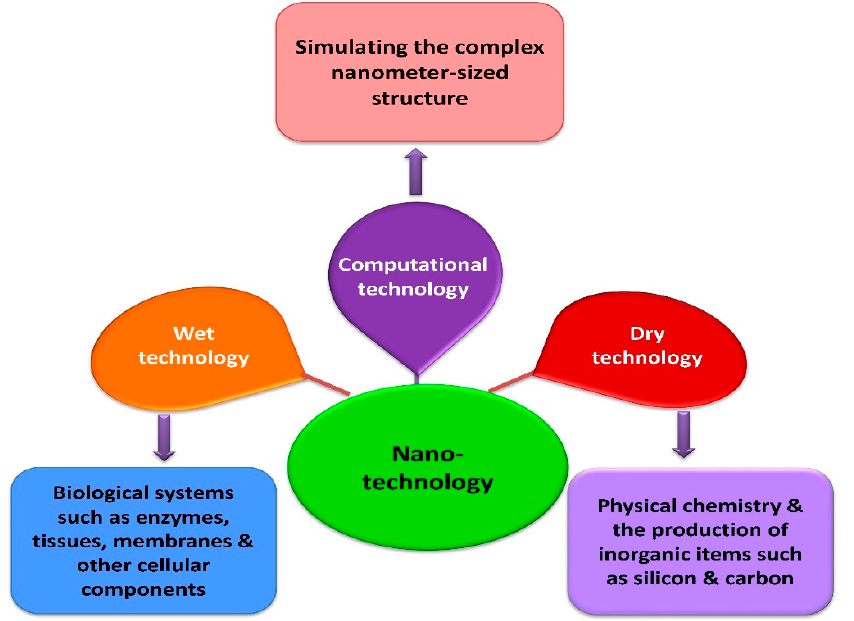
Figure 1. Different types of nanotechnologies.